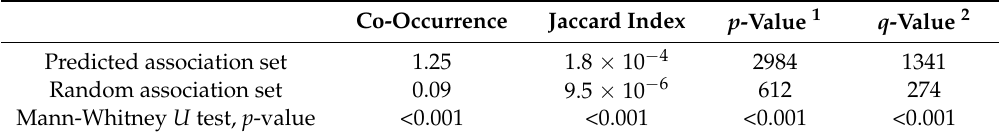
Table 5. Literature validation was performed by comparing co-occurrence, the Jaccard index and Fisher’s exact test values between predicted and random association sets. Statistical significance was calculated by the p -value of the Mann-Whitney U